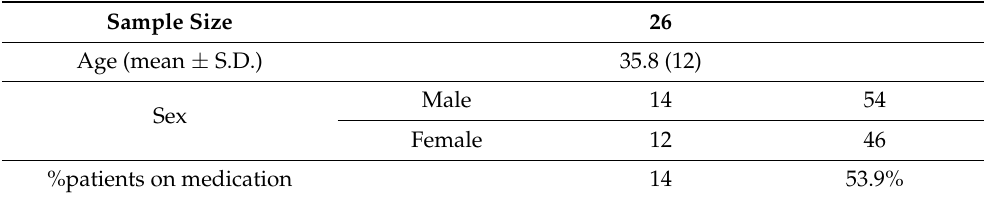
Table 1. Clinico-demographic data of patients with OCD at baseline.